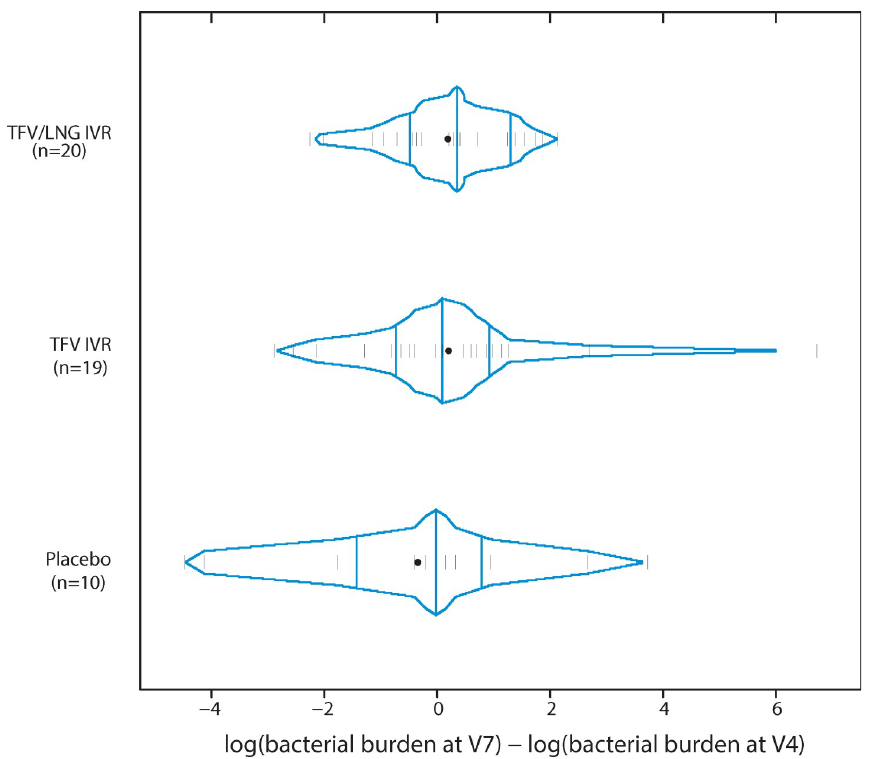
Fig 2. Differences of log absolute bacterial bioburden at visit 7 and visit 4 for TFV, TFV/LNG and placebo IVR users.